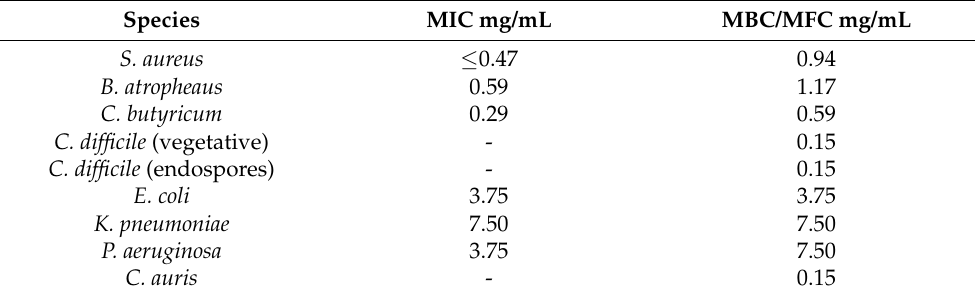
Table 1. Testing of GS-2 against bacterial and fungal pathogens using CLSI M26-A guidelines for 24 h. n = 6.